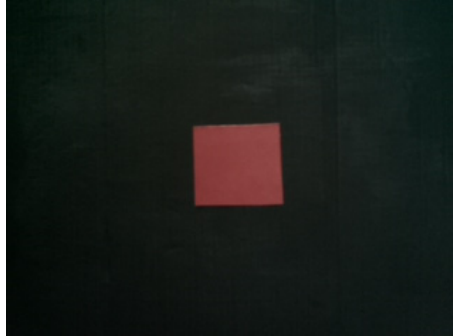
Figure 11. The robot’s objective is implemented as a red